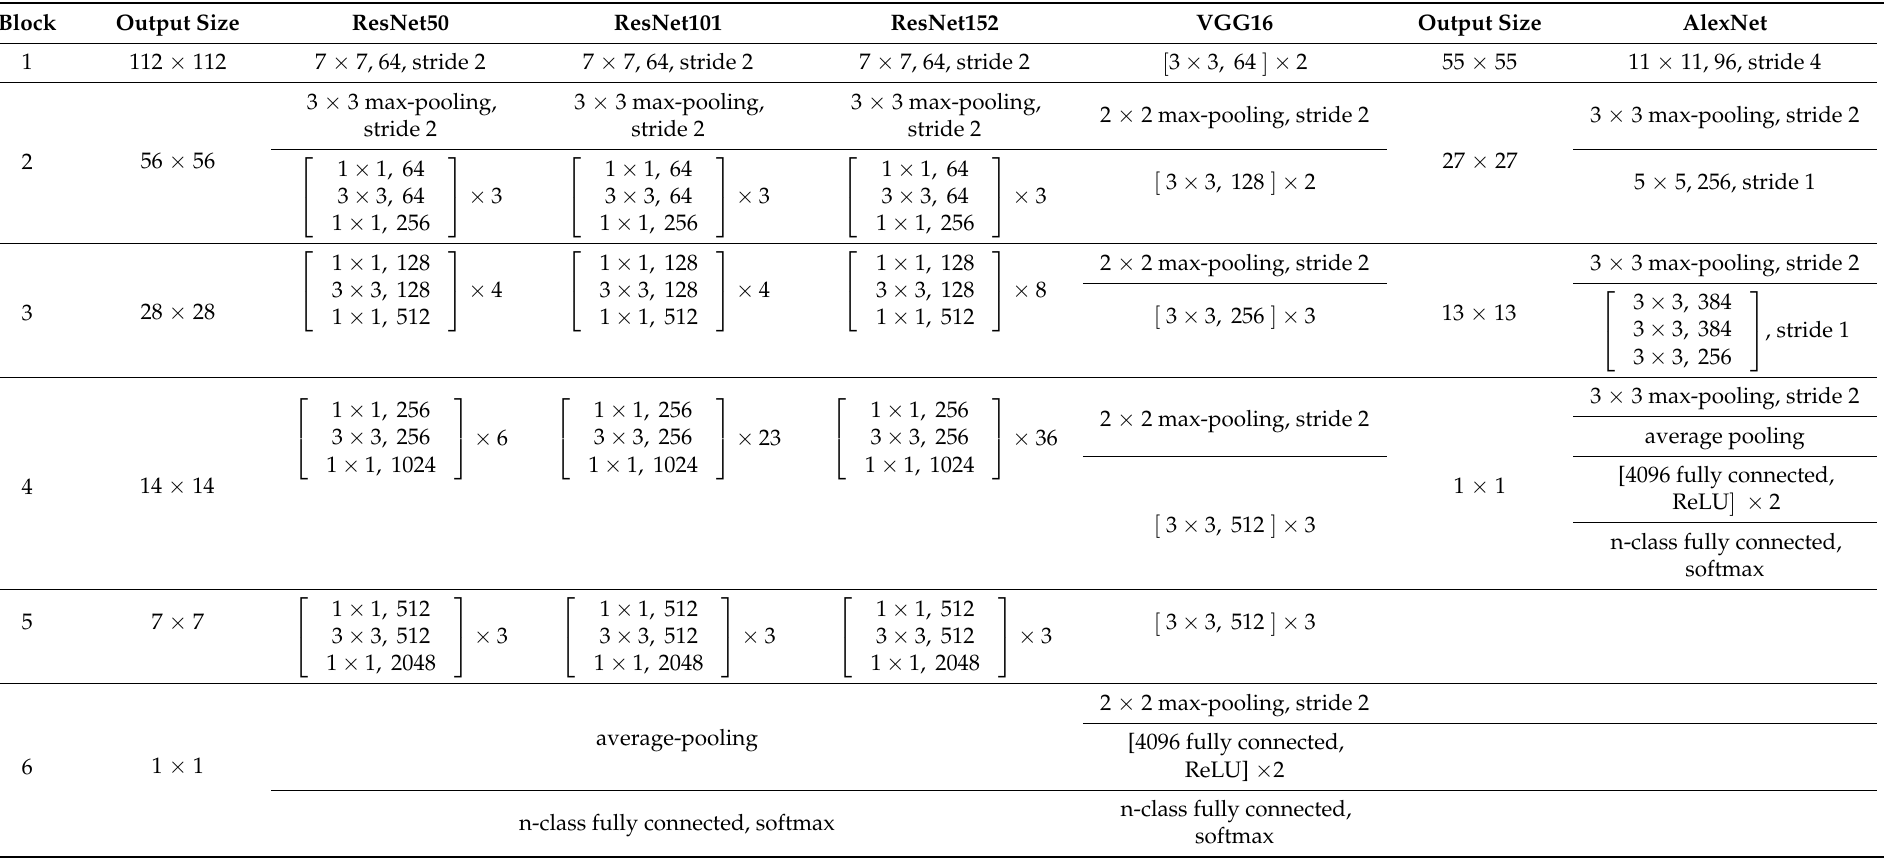
Table 4. Detailed configuration of ResNet50, ResNet101, ResNet152, AlexNet, and VGG16. Convolution and pooling layers of ResNet block 2, 3, 4, and 5 were performed with a stride of 2.